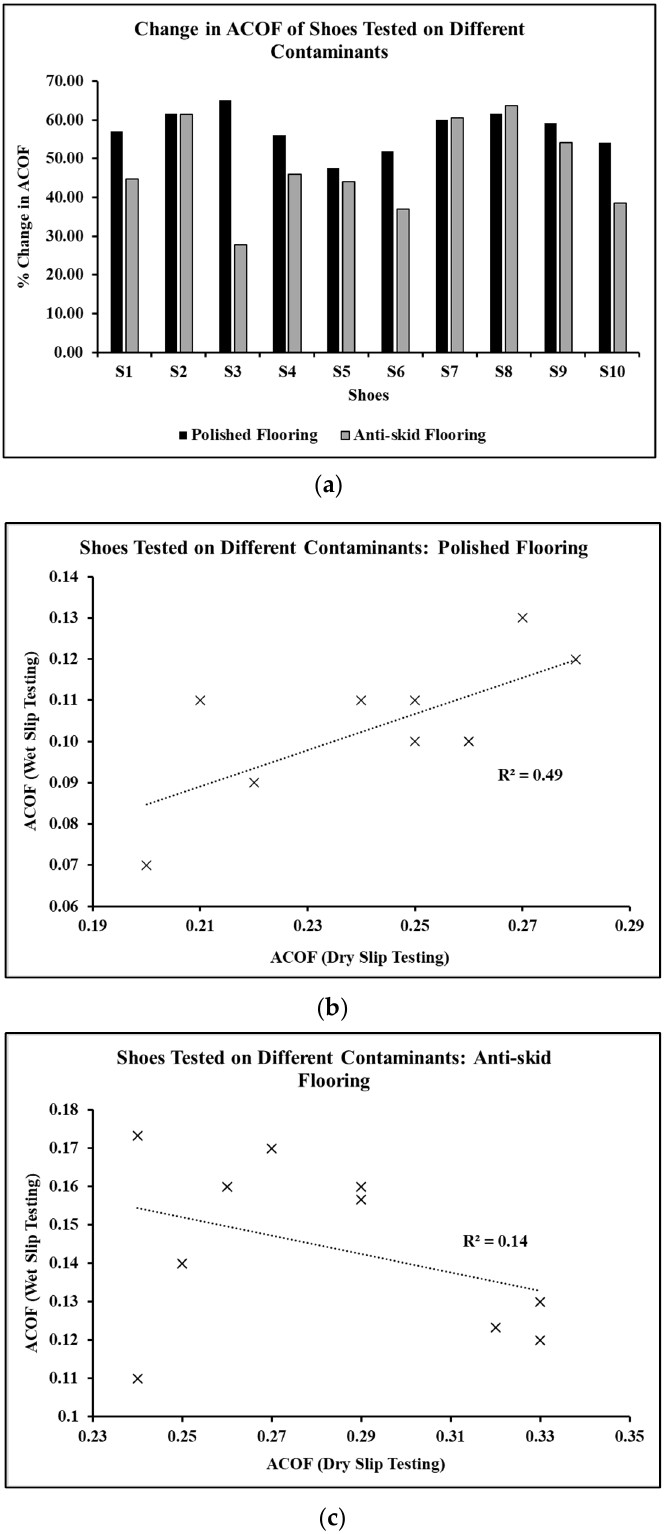
Figure 10. Ability of the slip tester to differentiate shoes tested on different contaminants in terms of ( a ) percentage difference in the ACOF between contaminants, ( b ) correlation of the ACOF of shoes between contaminants tested on polished flooring, and ( c ) correlation of the ACOF of shoes between contaminants tested on anti-skid flooring.